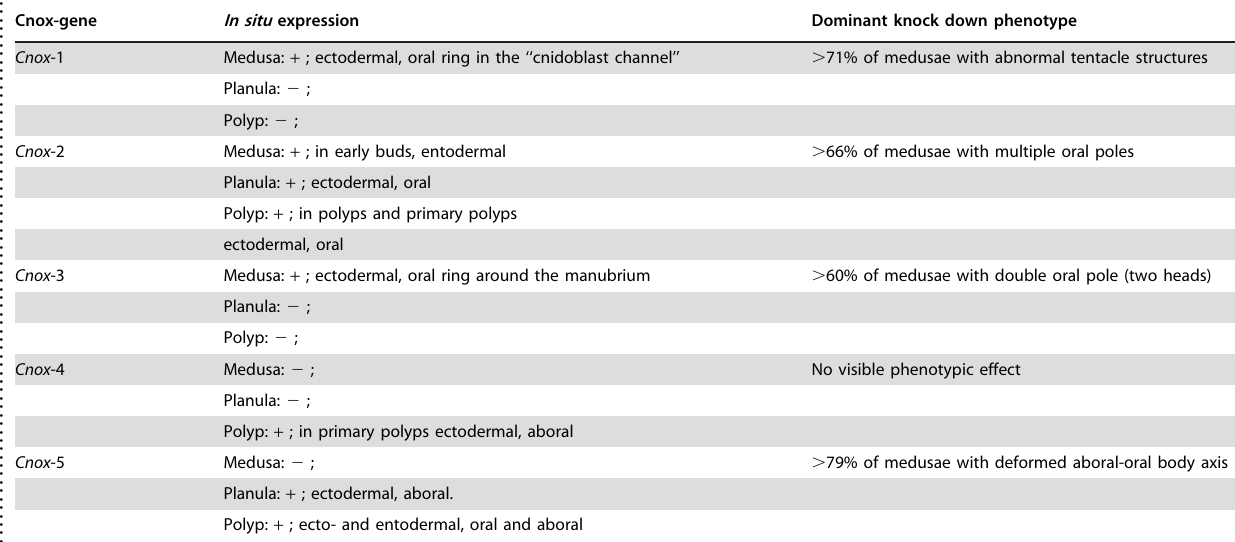
Table 1. Cnox gene expression and knock down phenotypes in the hydrozoan Eleutheria dichotoma . .. ... .... ... ... .... ... ... .... ... ... .... ... ... .... ... ... .... ... ... .... ... ... .... ... ... .... ... ... .... ... ... .... ... ... .... ... ... .... ... ... .... ... ... . Cnox-gene